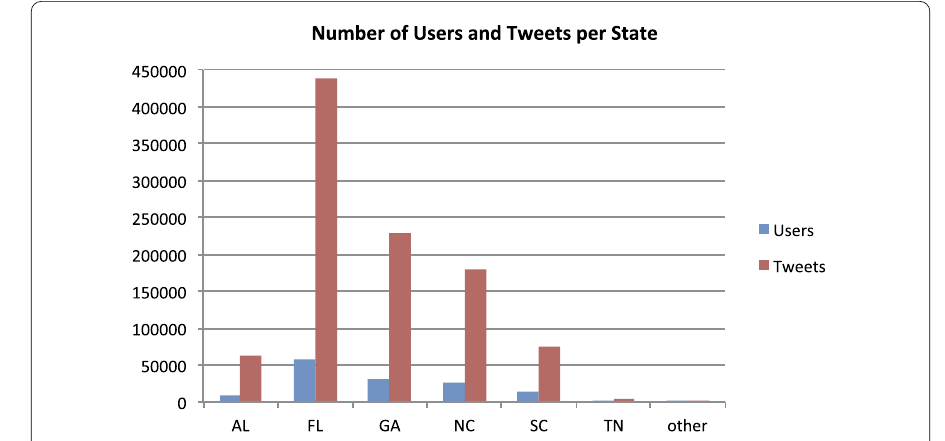
Figure 2 Number of users and tweets per